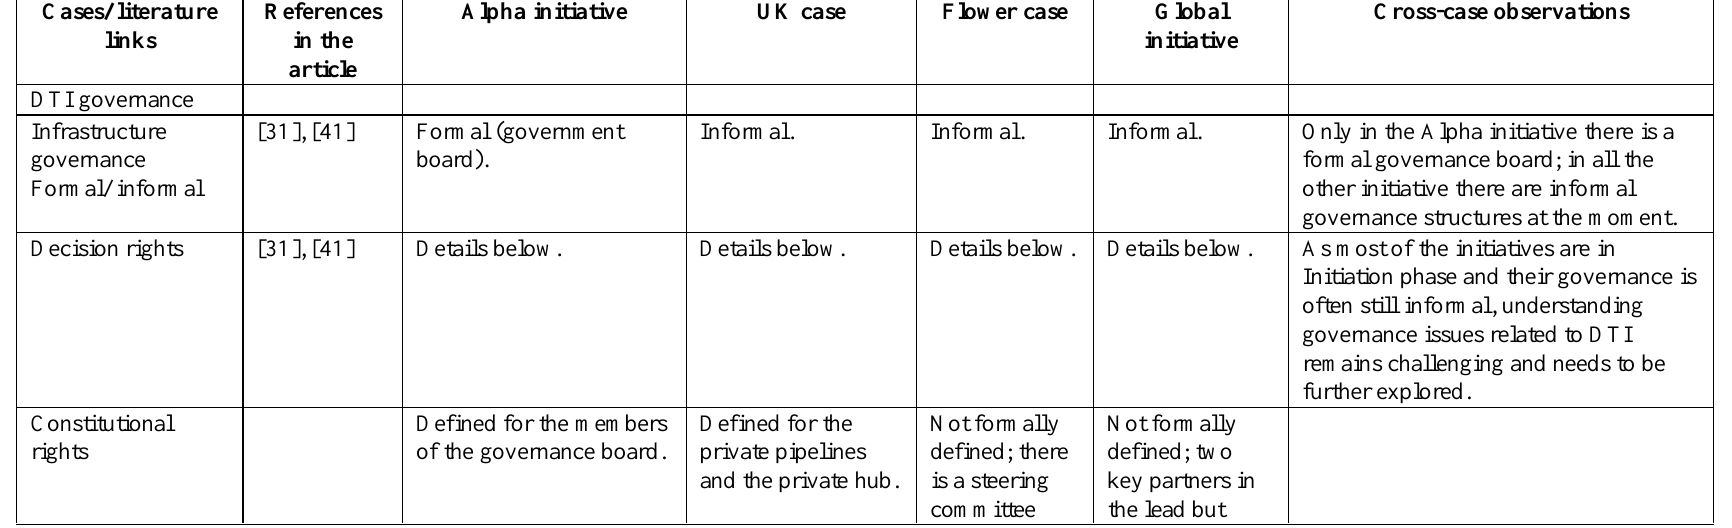
Table A3. The governance component of the DTI framework and links to the four cases and the references of the